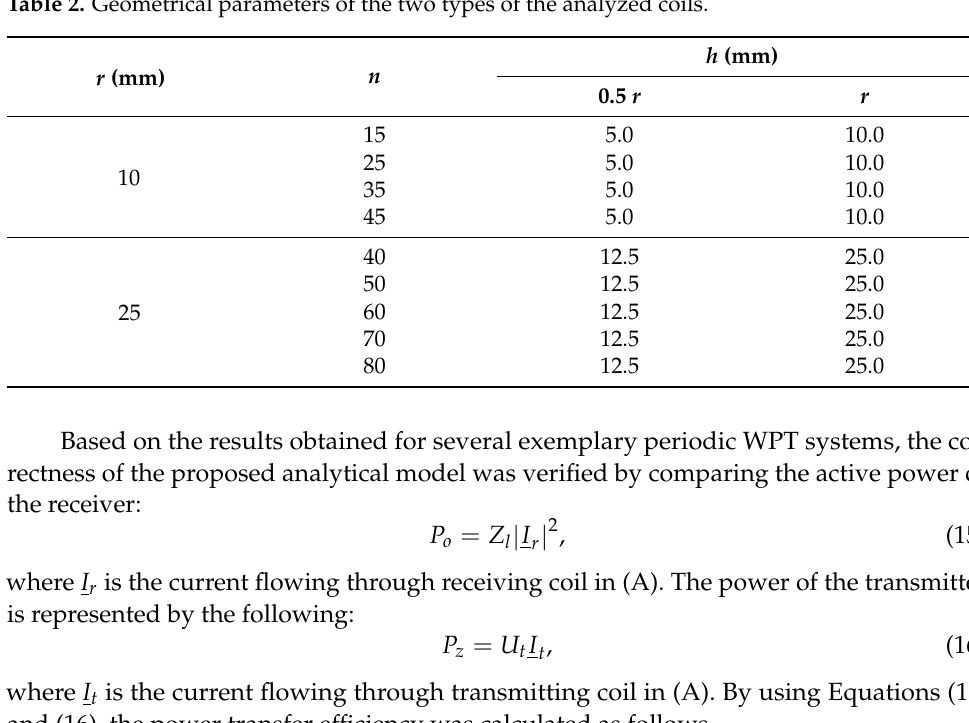
Table 2. Geometrical parameters of the two types of the analyzed